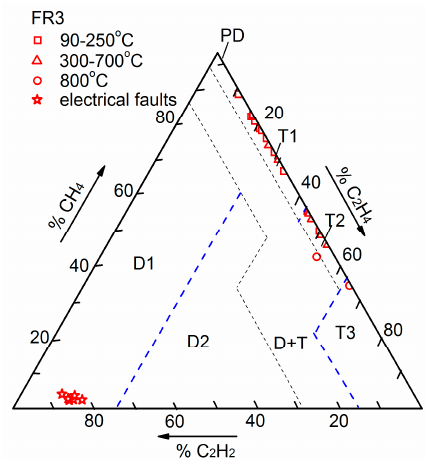
Figure 20. Diagnostic results of thermal and electrical faults of FR3 oil using Duval Triangle 3 (data in the figure are expressed as a function of oven temperature).